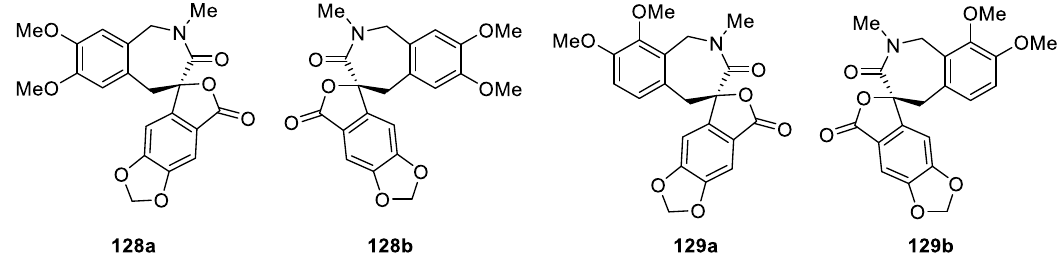
Figure 61. Enantiopure juglanaloid A ( 128a – b ) and juglanaloid B ( 129a – b ) isolated from Juglans mandshurica and further obtained by chiral separation.